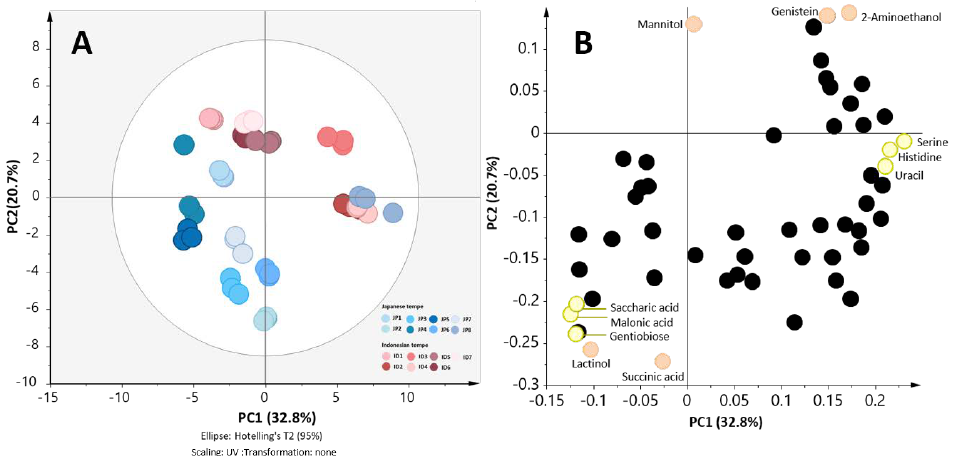
Figure 4. The PCA score and loading of the validation set. ( A ) This figure shows PCA score scatter plot of metabolite profiles of eight Japanese industries (coded JP1-JP8) and seven Indonesian industries (coded ID1-ID7). Along PC2, tempe samples were clustered based on the origin except for JP8. ( B ) Some of the most contributing metabolites to this separation were mannitol, genistein, 2-aminoethanol, succinic acid, lactinol, and gentiobiose.